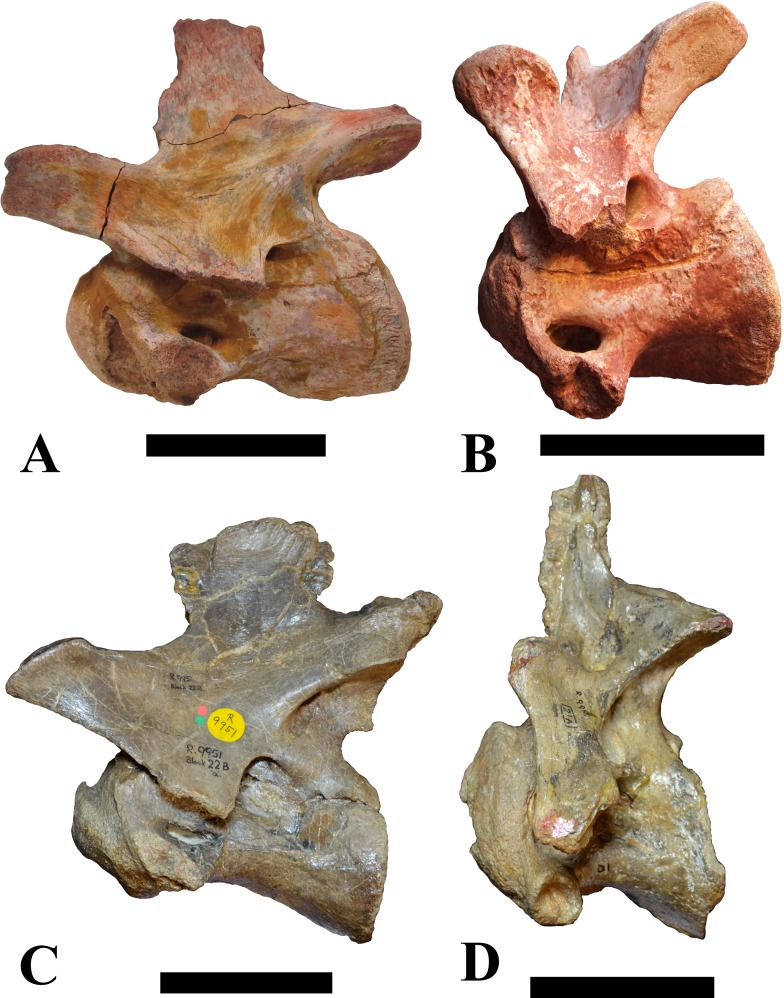
Morphological changes along the cervical vertebral column of Sigilmassasaurus andBaryonyx.(A) CMN 50791, holotype mid-cervical vertebra (C6) of Sigilmassasaurus brevicollis in left lateral view; (B) BSPG 2005 I 56, posterior cervical vertebra (C8) of Sigilmassasaurus brevicollis in left lateral view; (C) NHMUK PV R 9951, C6 of Baryonyx walkeri in left lateral view; (D) NHMUK PV R 9951, C9 of Baryonyx walkeri in left lateral view. Note the extreme morphological changes in centrum length, orientation of prezygapophzses, and shape of the neural spine in both taxa. For discussion of axial placement of Baryonyx vertebrae see main text. Scale bars equal 10 cm.